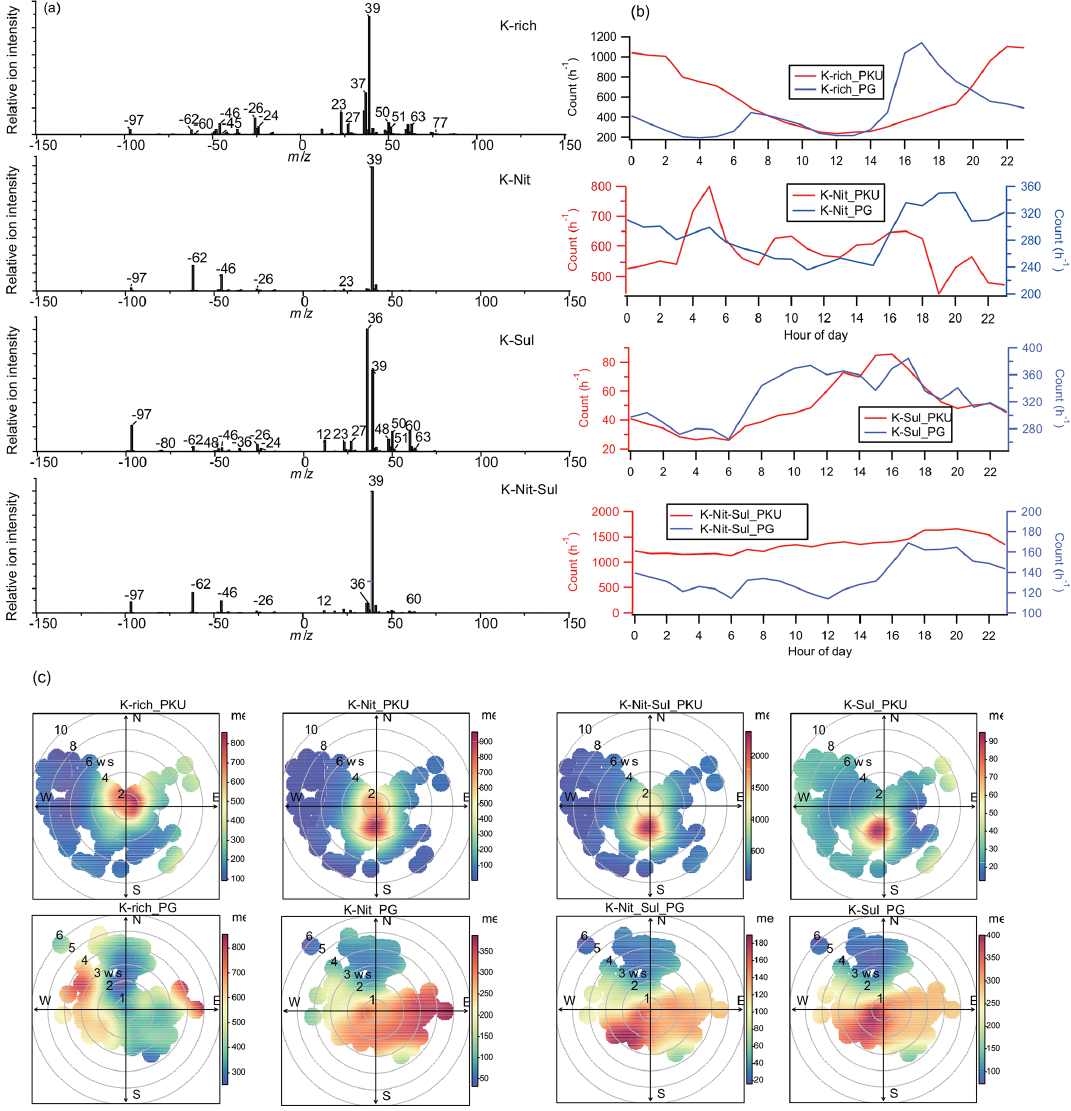
Figure 6. (a) Average mass spectra of BB, K-Nit, K-Sul, and K-Nit-Sul observed at both sites; (b) diurnal patterns of the hourly count of K-rich, K-Nit, K-Sul, and K-Nit-Sul at both sites; (c) polar plots of BB, K-Nit, K-Sul, and K-Nit-Sul; the gray circles indicate wind speed (ms 1